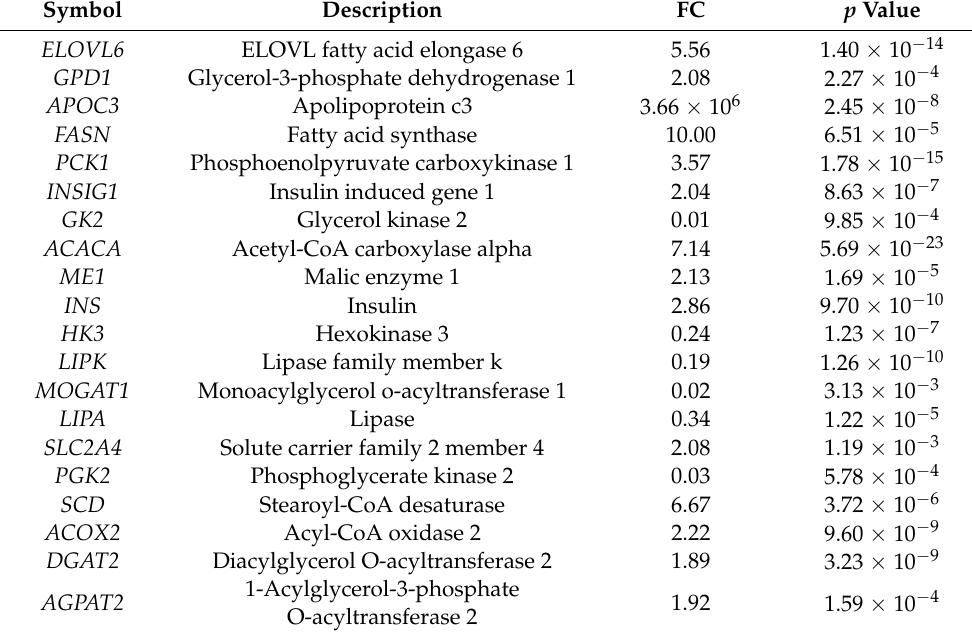
Table 3. The information of crucial differentially expressed genes (DEGs) in the regulation of fat metabolism in yak subcutaneous